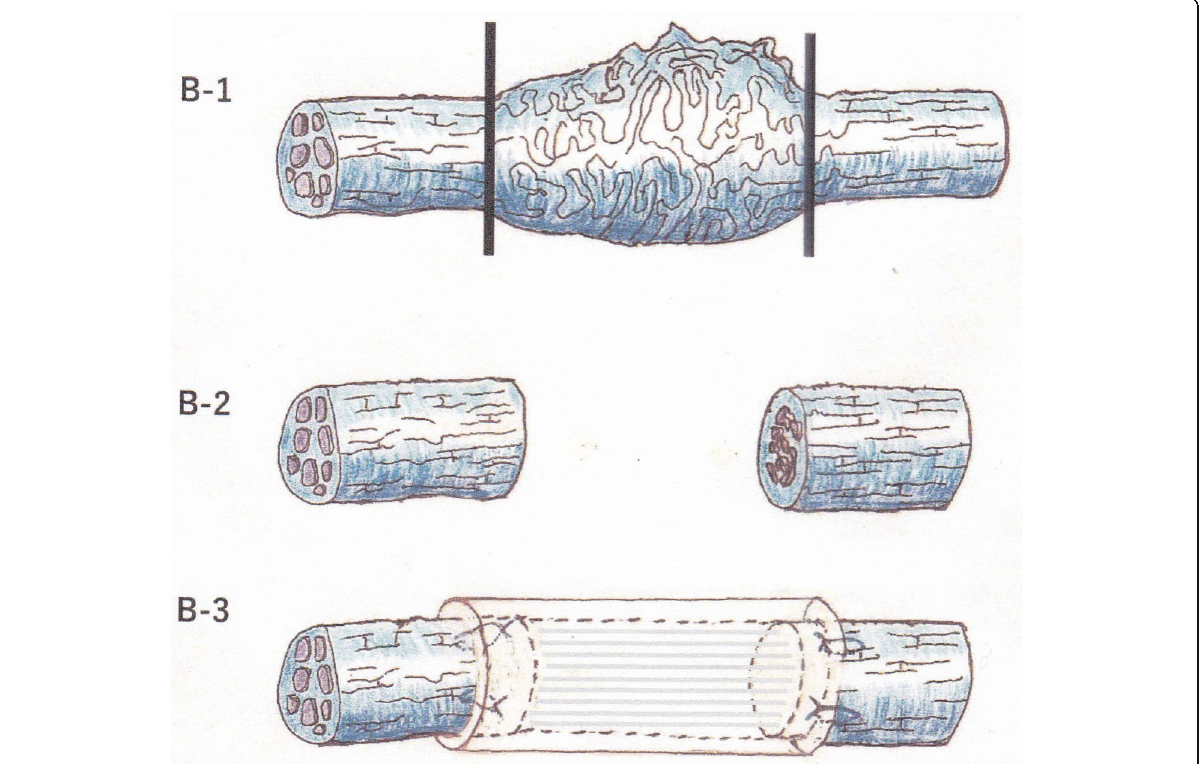
Fig. 2 Interpositional collagen allograft repair. B-1:Nerve stump preparation. Neuroma resection at the clinical margin of the neuroma fails to complete nerve preparation. B-2:After complete excision of the injured and degenerated nerve, a healthy bilateral stump surface is revealed. B- 3:An artificial collagen nerve graft, Renerve Ⓡ , which is several millimeters longer than the nerve gap, is inserted between ends of healthy nerve stumps and sutured with 8-0